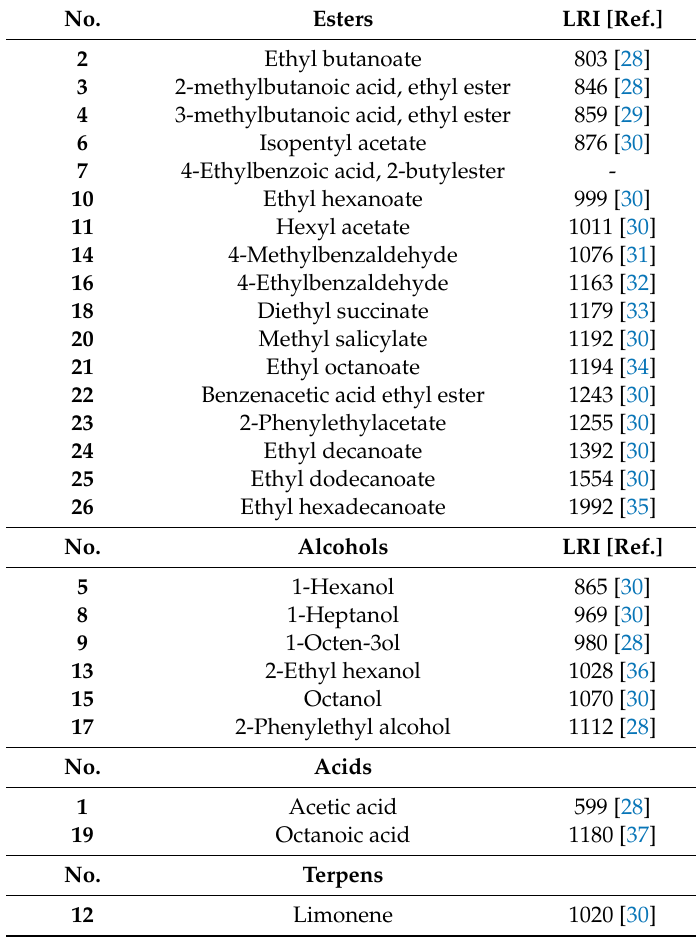
Table 4. List of volatile compounds (LRI, linear retention